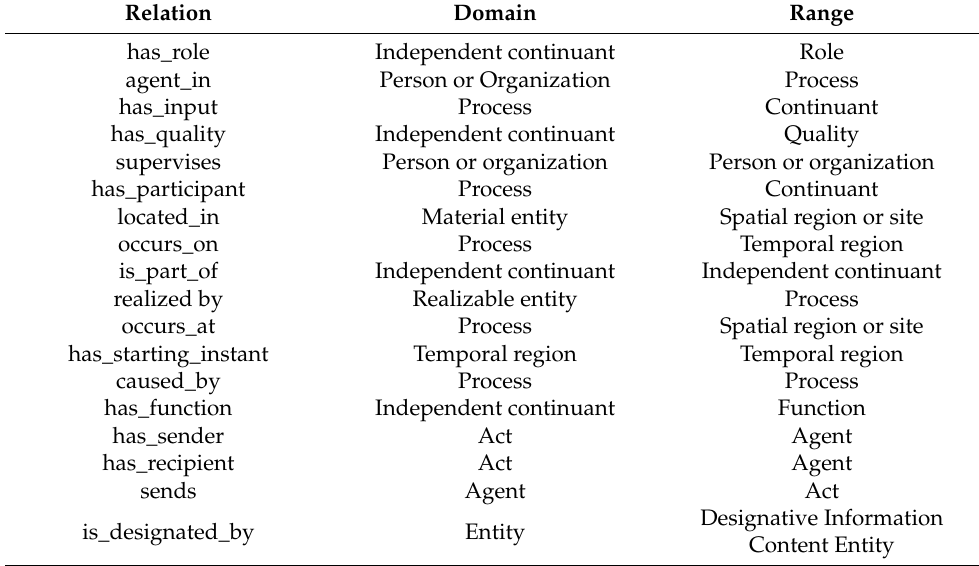
Table 3. The reused RO-Bridge